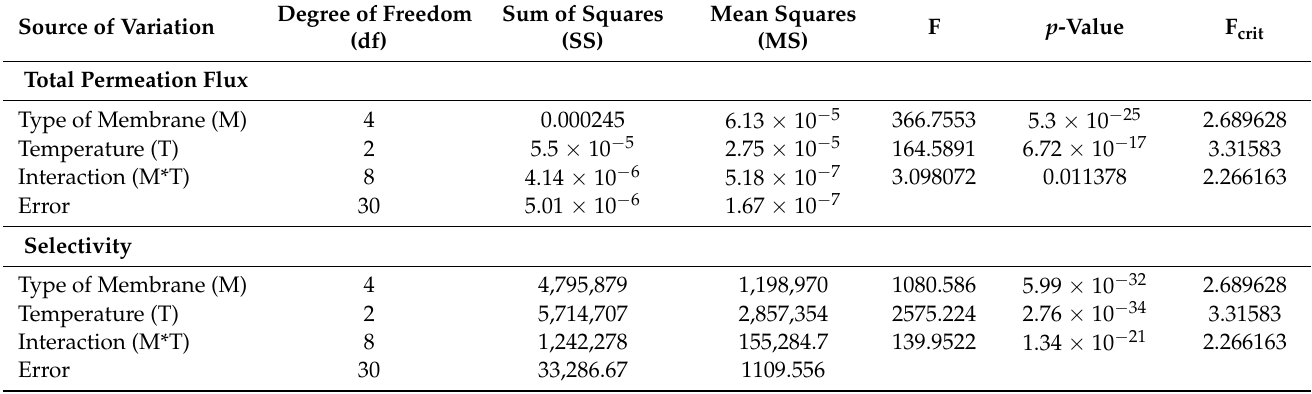
Table 7. Analysis of variance for total permeation flux and selectivity vs. membrane type and